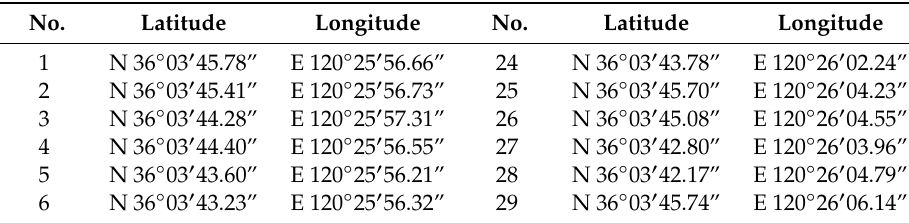
Table A2. Location coordinates of 45 planned